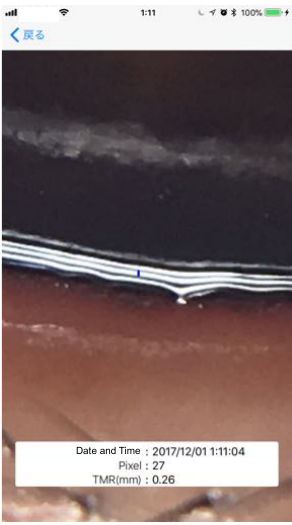
Figure 8. A representative example of smartphone screen after calculating TMR of human subject. Measured date, time, pixels of blue line and TMR were indicated at below.